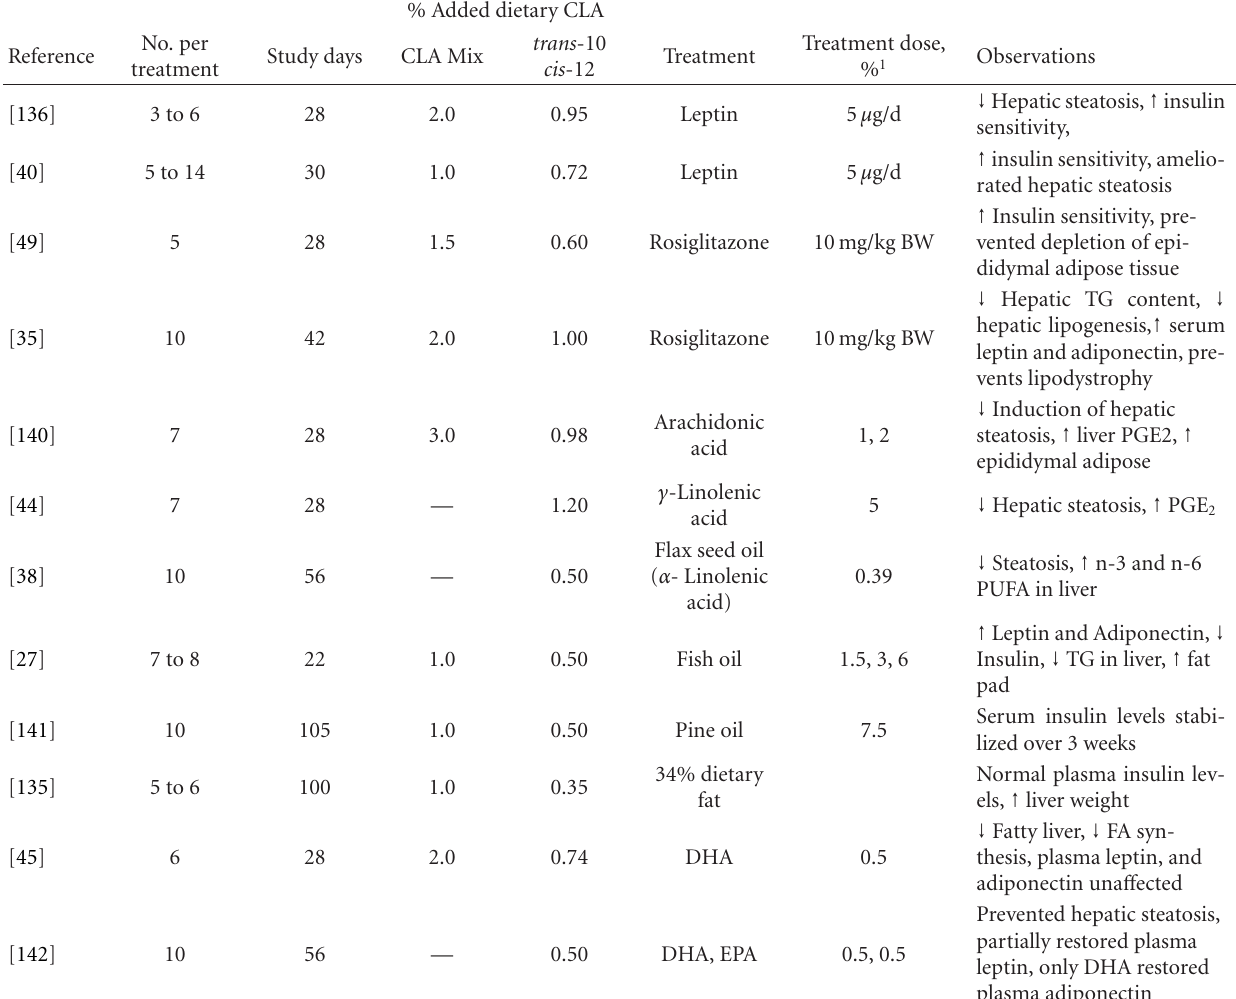
Table 3: Summary of literature studies on amelioration of CLA induced hepatic